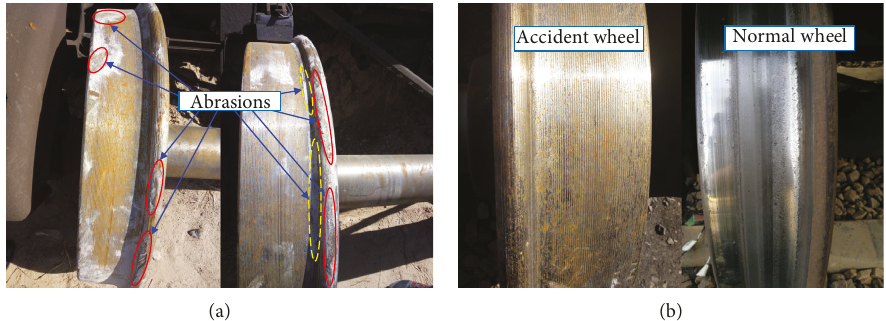
Figure 4: Wheel surface condition: (a) the abrasions on wheels of the accident wagon; (b) the comparison of the accidental and normal